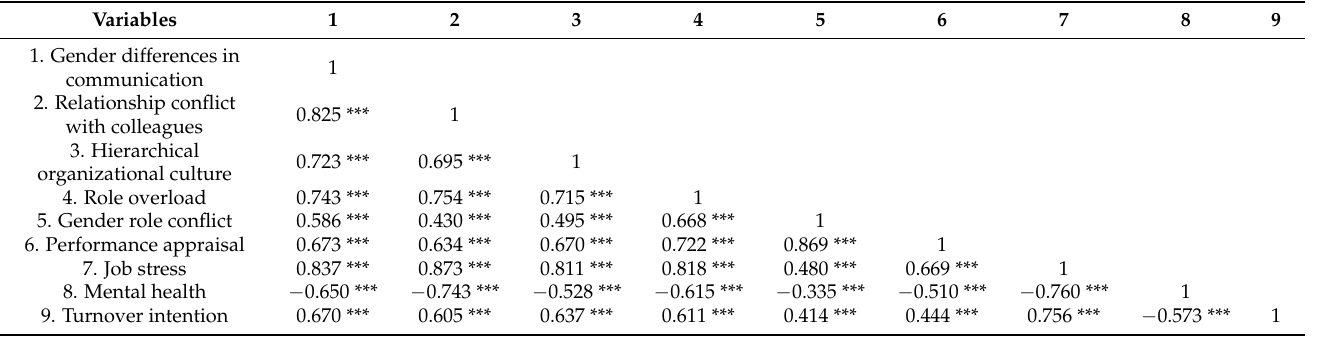
Table 4. Correlation analysis